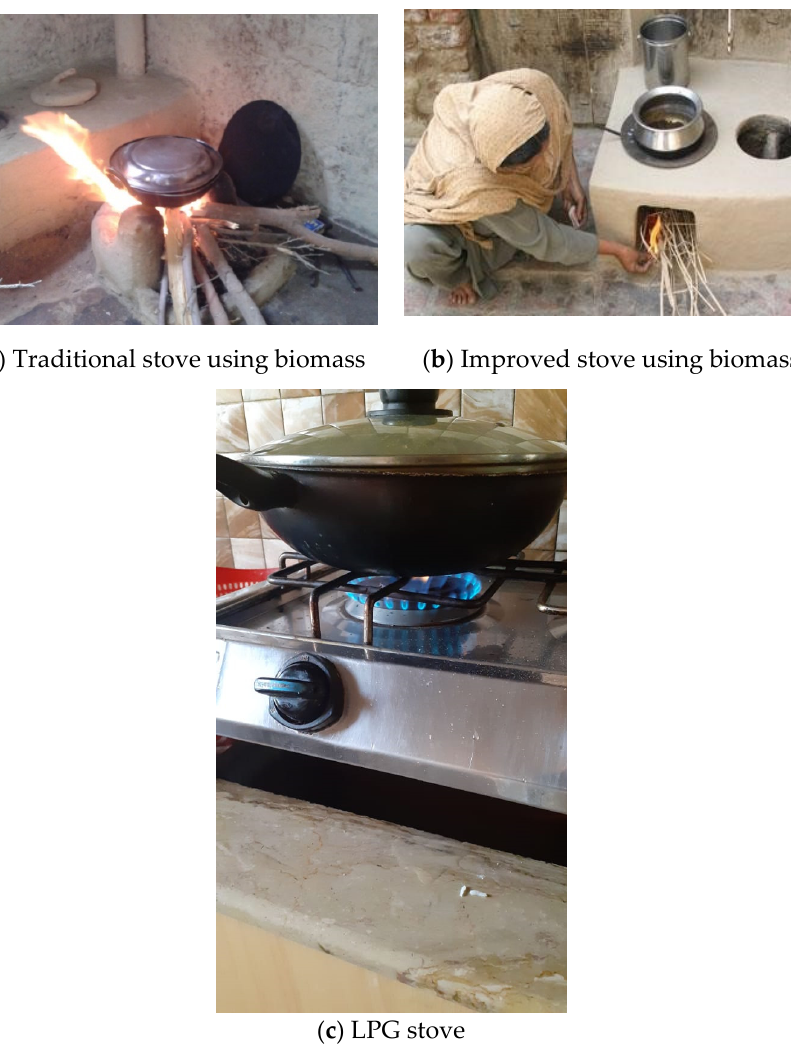
Figure 1. Methods of cooking in the study population.